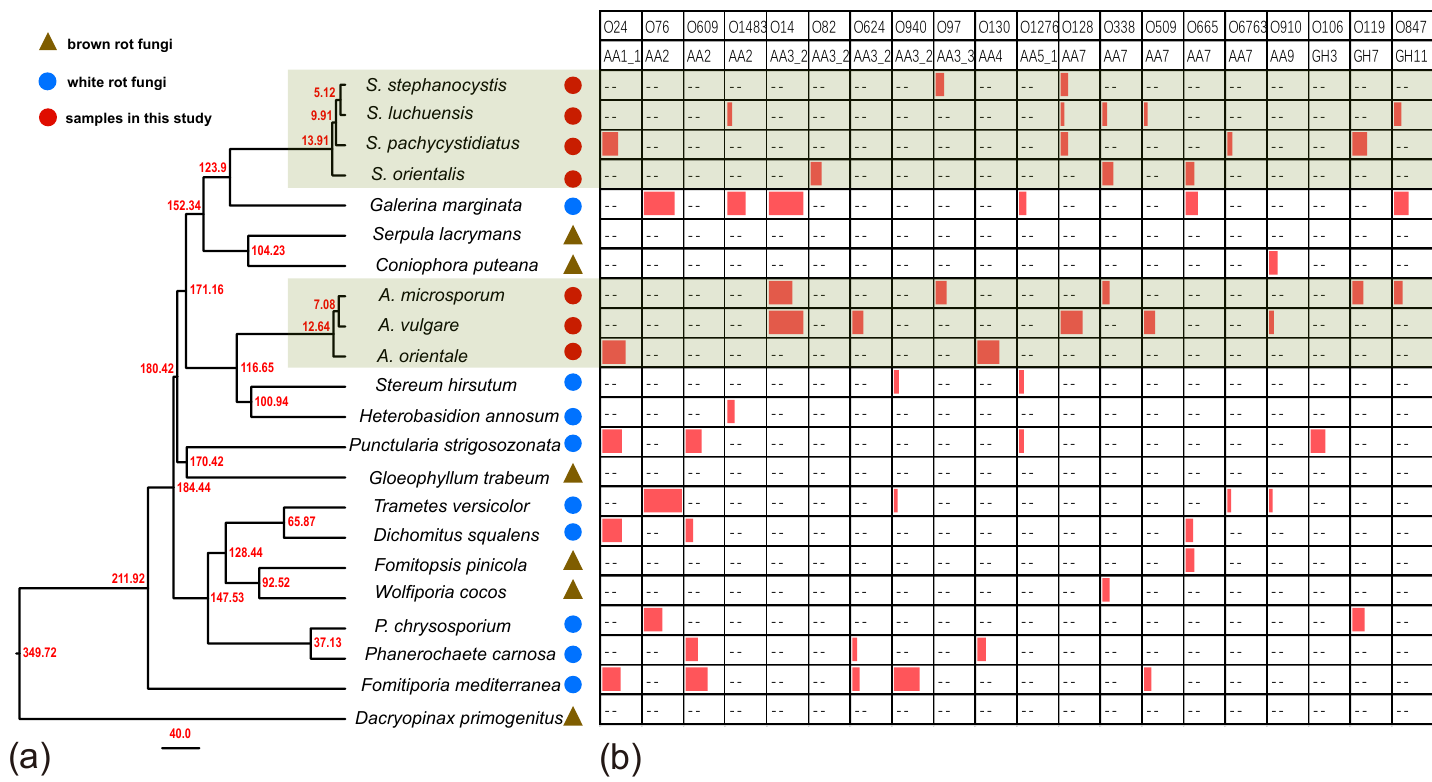
Figure 5. Phylogenetic tree of fungi in Auriscalpium and Strobilurus with other 15 fungal species and gene family expansions of CAZymes using CAFE. ( a ) The topology of the phylogenetic tree was constructed by the maximum likelihood method and divergence time estimation using r8s. Their divergence time was marked on the phylogenetic tree with time scale being shown by MYA (million years ago). ( b ) gene family expansions of CAZymes in 22 fungi with p-values less than 0.05. “O” in the first row of the table represents OCG (Ortholog Cluster Group); The second row of the table represents the gene family information of CAZymes. The length of the red rectangle represents the quantity; “–“ represents that the gene family has not been significantly expanded in this